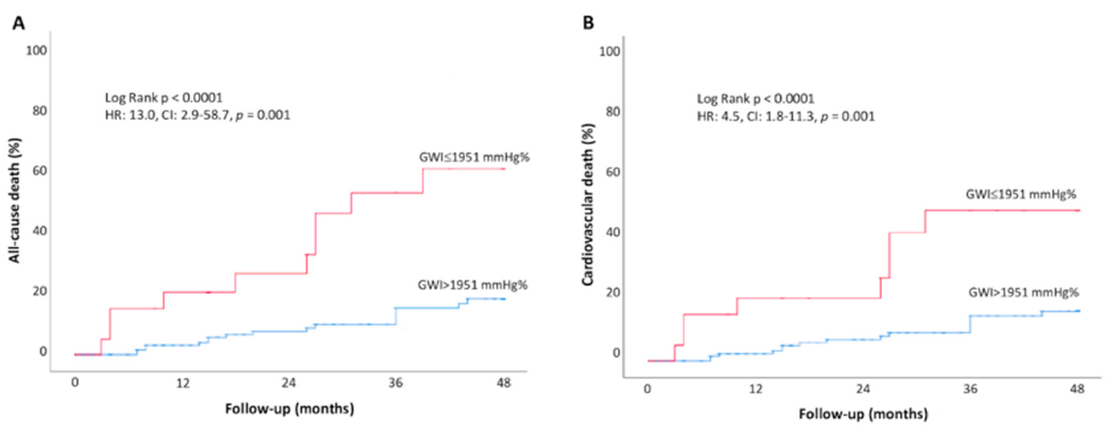
Figure 4. Kaplan–Meier estimates for all cause of death ( A ) and cardiovascular death ( B ) during follow-up in asymptomatic AS patients divided in two groups according to baseline more impaired GWI ( ≤ 1951 mmHg%, blue line) vs. more preserved GWI (>1951 mmHg%, red line).